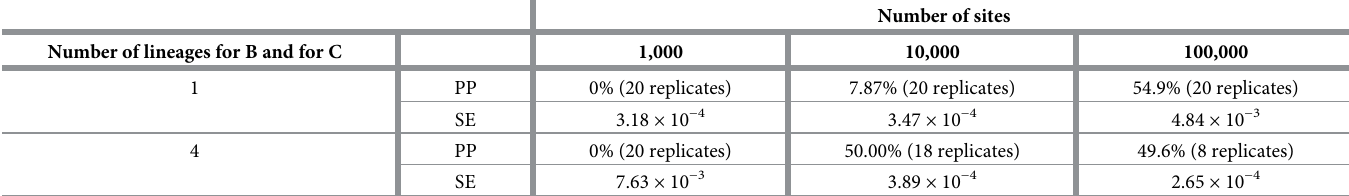
Table 2. Average posterior probability (PP) of the topology of network C obtained by running S NAPP N ET on data simulated from network C. Results are given as a function of the number of sites and as a function of the number of lineages sampled in hybrid species B and C (either both 1 or both 4). Only one lineage was sampled in every other species. Constant sites are included in the analysis and the rates u and v are considered as known. Posterior probabilities are computed on the basis of replicates for which the criterion ESS > 100 is fulfilled. The sampler efficiency (SE) is also indicated (true hyperparameter values for the prior on θ , i.e. θ * Γ (1, 200); as a network